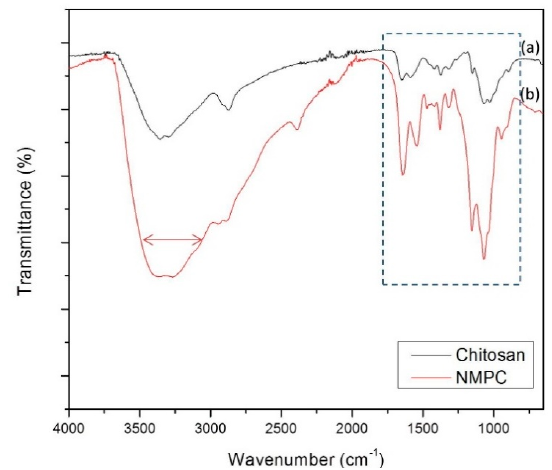
Figure 2. FTIR (Fourier transform infrared) spectra of ( a ) chitosan and ( b ) N -methylene phosphonic chitosan (NMPC).